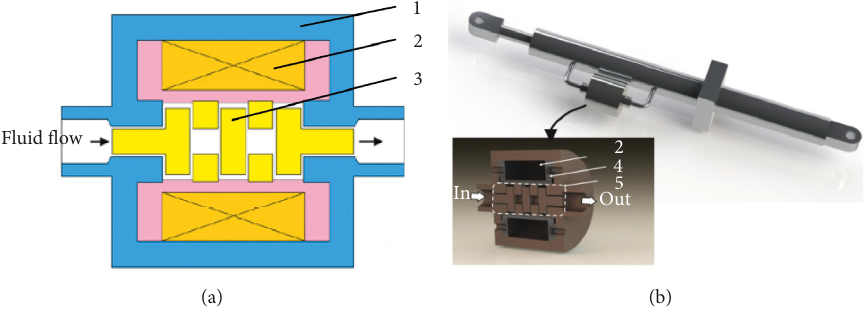
Figure 33: (a) Schematic view of the MR valve with a meandering flow path [74, 75]. (b) Photograph of bypass MR damper concept with meandering type valve. 1, casing; 2, electromagnet coil; 3, core; 4, coil bobbin; 5, meandering path [76].